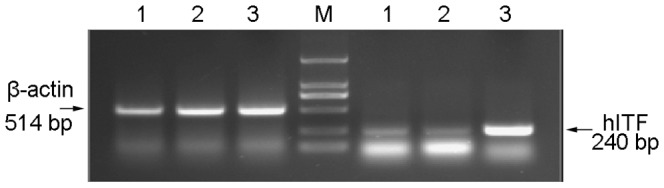
Agarose gel (1.2%) electrophoresis of the reverse transcription-polymerase chain reaction (RT-PCR) product.HT-29 cells were infected with the recombinant Ad-hITF adenovirus or the empty Ad-EGFP virus. Two days after viral infection, total RNA was extracted and detected using RT-PCR. Lane 1, HT-29 cells; Lane 2, infection with Ad-EGFP; Lane 3, infection with Ad-hITF; Lane M, DL2000 marker.